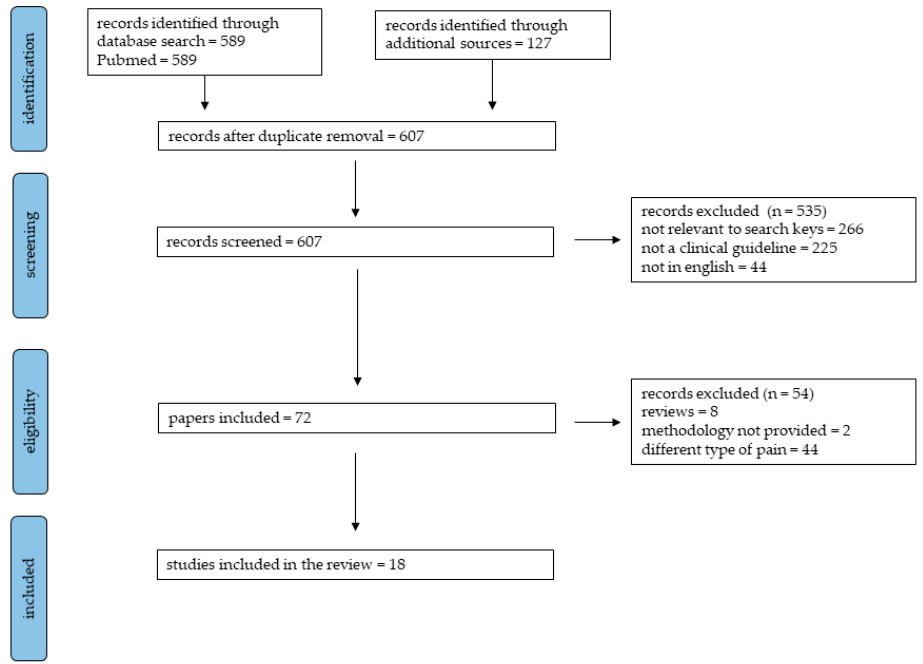
Figure 1. Flowchart of study screening, eligibility and inclusion.